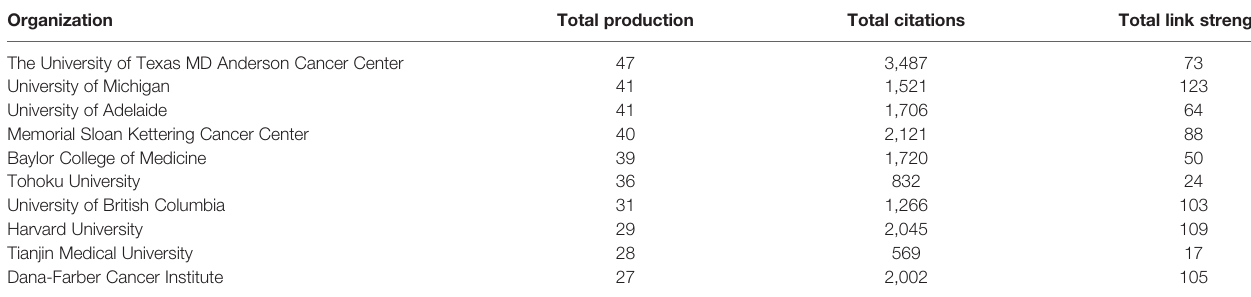
TABLE 2 | Most productive organizations contributing to this research fi eld.